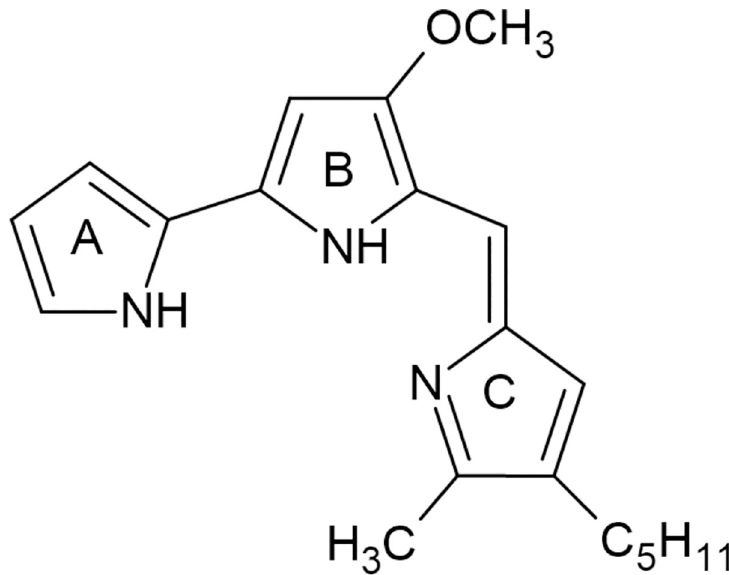
Fig 1. The structure of prodigiosin. The three rings, A, B and C made up the tripyrrole structure of prodigiosin (Adapted from Williamson et al. [3]).